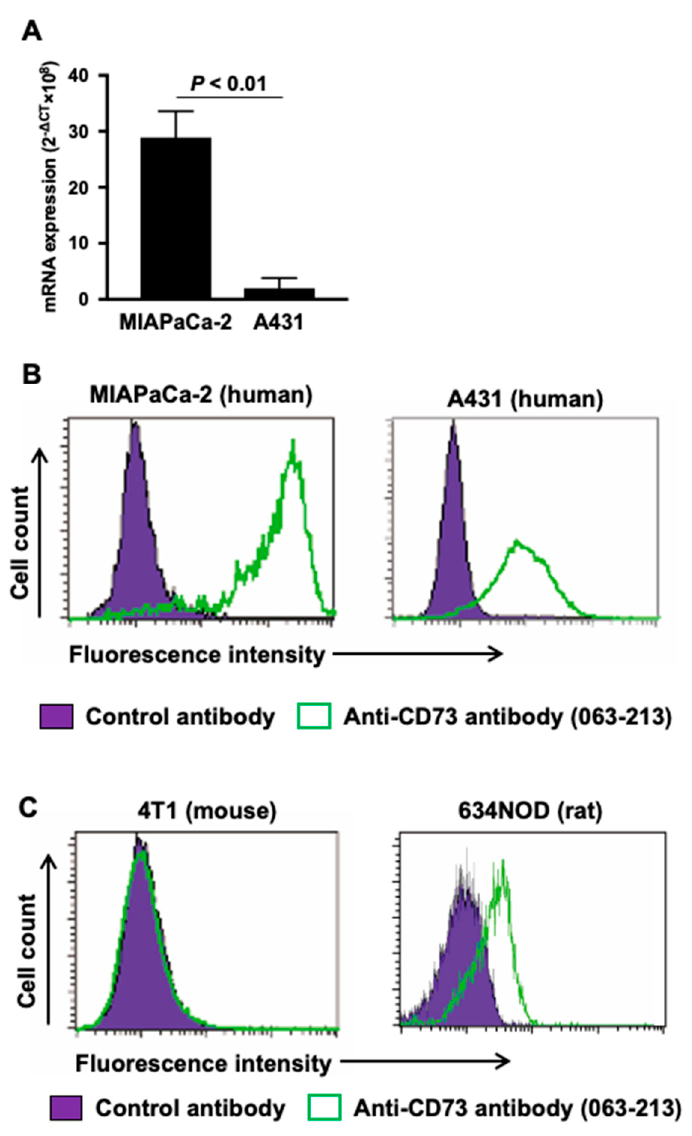
Figure 1. ( A ) CD73 mRNA expression analysis in MIAPaCa-2 and A431. ( B ) Flow cytometric analysis of anti-CD73 antibody 067-213 to two human cancer cell lines MIAPaCa-2 and A431. ( C ) Flow cytometric analysis of anti-CD73 antibody 067-213 to mouse and rat cell lines 4T1 and 634NOD. Green, anti-CD73 antibody; purple, control antibody.